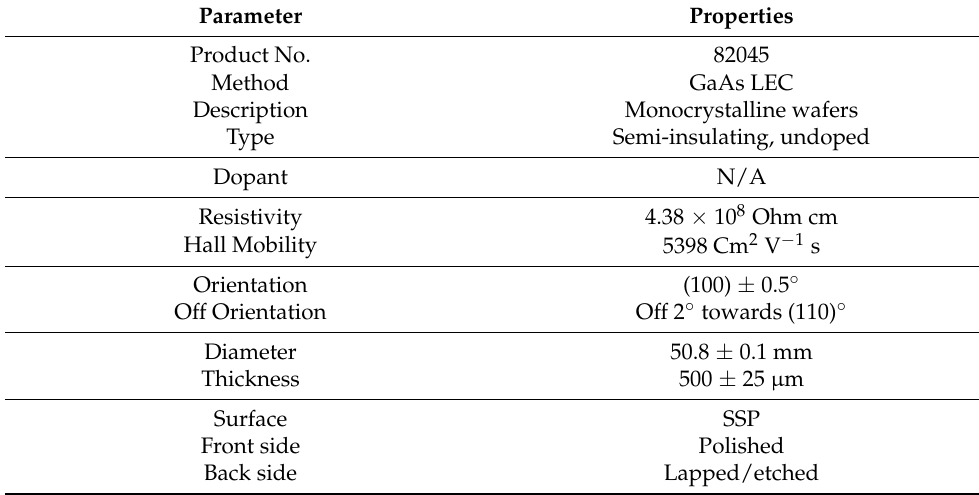
Figure 1. As-prepared test samples of the GaAs as per Table 1 for the irradiation experiment.